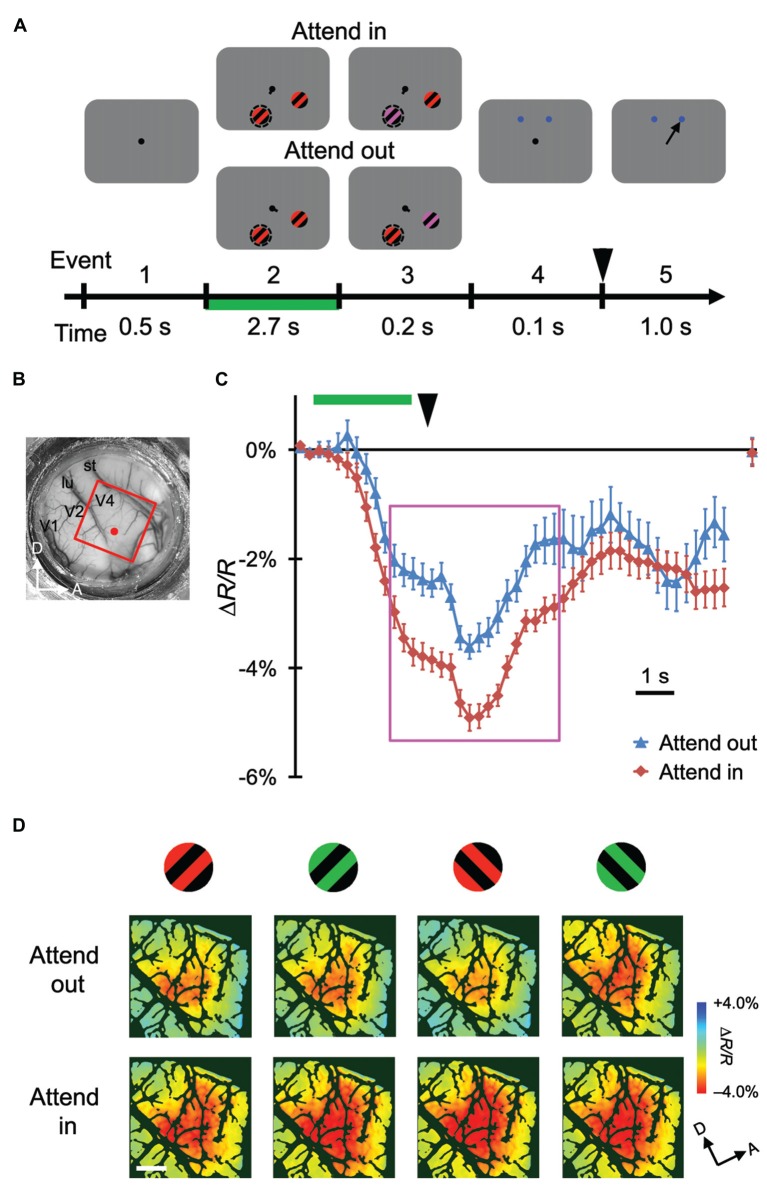
Stimulus-evoked hemodynamic responses in different attentional conditions. (A) Sequence and duration of events in a trial of the covert attention task for monkey M1. Broken circles and solid arrows indicate the cued location and correct saccade, respectively, but were not actually present on the monitor. (B) A view of the cortical surface of M1, including dorsal V4, through the chamber. The red rectangle indicates the imaged region for this monkey. (C) Examples of time courses of average stimulus-evoked reflectance change from the baseline under 570 nm illumination. The sampled site is indicated by a red dot in (B). Error bars represent standard error of the mean (SEM). The rightmost plot indicates the reflectance change from the baseline, measured at the beginning of pre-stimulus period of the subsequent trial. Green horizontal line and black arrowhead indicate the period of stimulus presentation before color change and the timing of disappearance of fixation dot, respectively. These features are also shown in (A). (D) The top and bottom panels show maps of reflectance changes evoked by four different stimuli, as indicated on the top, obtained in the imaged region under attend-out (top) and attend-in (bottom) conditions respectively. To make these maps, we averaged the signals from 2 s–6.5 s after the stimulus onset, as indicated by the magenta rectangle in (C), on a pixel-by-pixel basis, and applied blank subtraction to extract stimulus-evoked signals (see “Materials and Methods” Section). Color scale indicates percent change from the baseline. Dark green regions indicate pixels with large cross-trial variability (see “Materials and Methods” Section). A, anterior; D, dorsal; lu, lunate sulcus; st, superior temporal sulcus. Scale bar represents 1 mm.